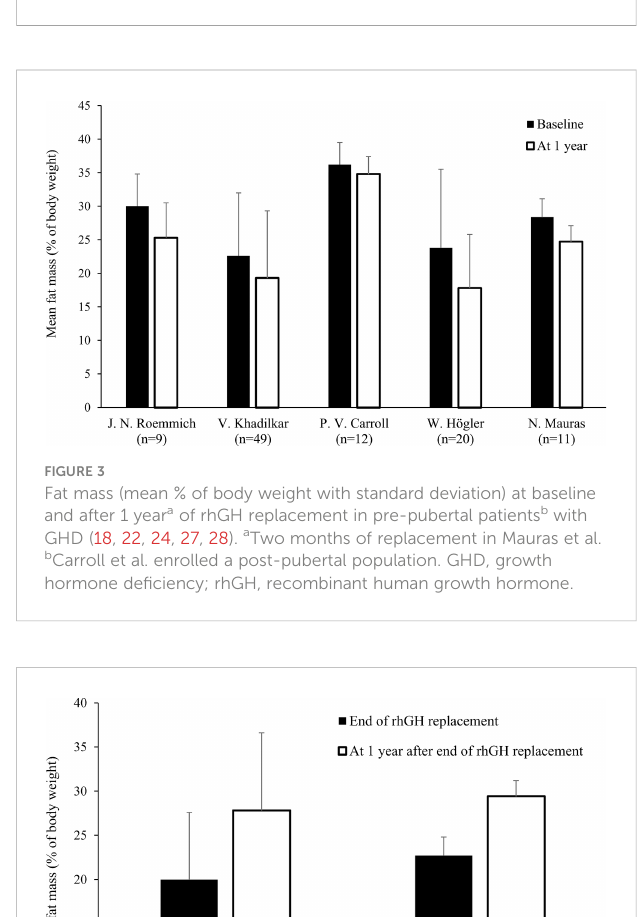
FIGURE 2 Differences in fat mass (mean % of body weight with 95% con fi dence interval) from the start to 1 year a of rhGH replacement in pre-pubertal patients b with GHD (18, 22, 24, 27, 28). a Two months of replacement in